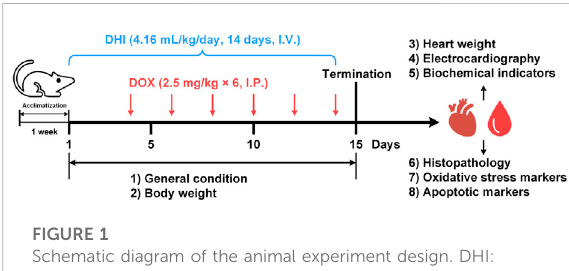
FIGURE 1 Schematic diagram of the animal experiment design. DHI: Danhong injection; DOX: doxorubicin; I.V.: intravenously; I.P.: